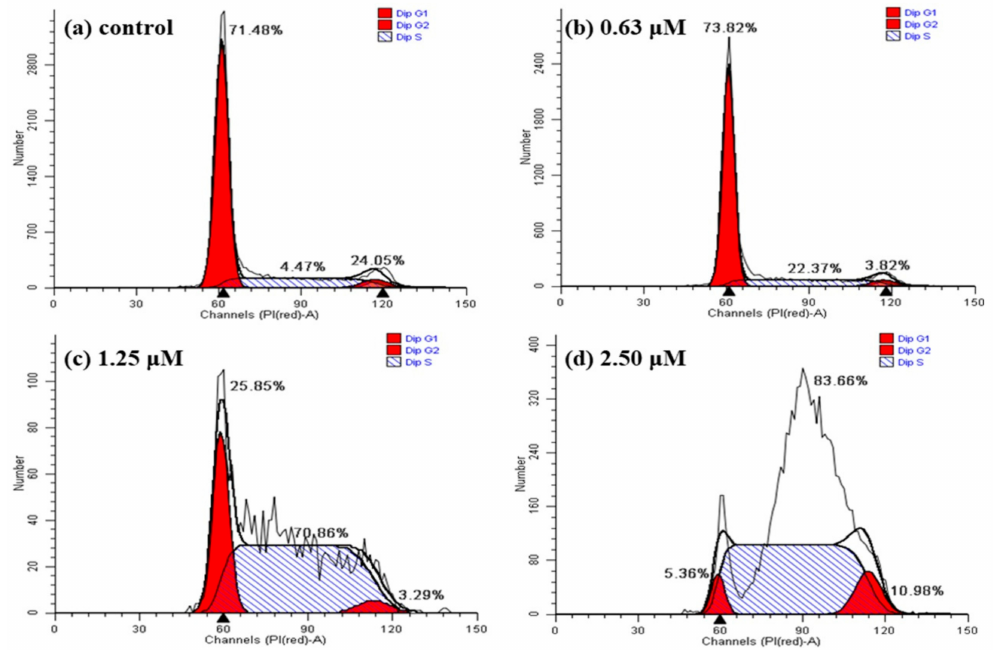
Figure 8. Effect of CPT-HT-J-ZL 12 on cell cycle progression in LNCaP-FGC cells (high expression